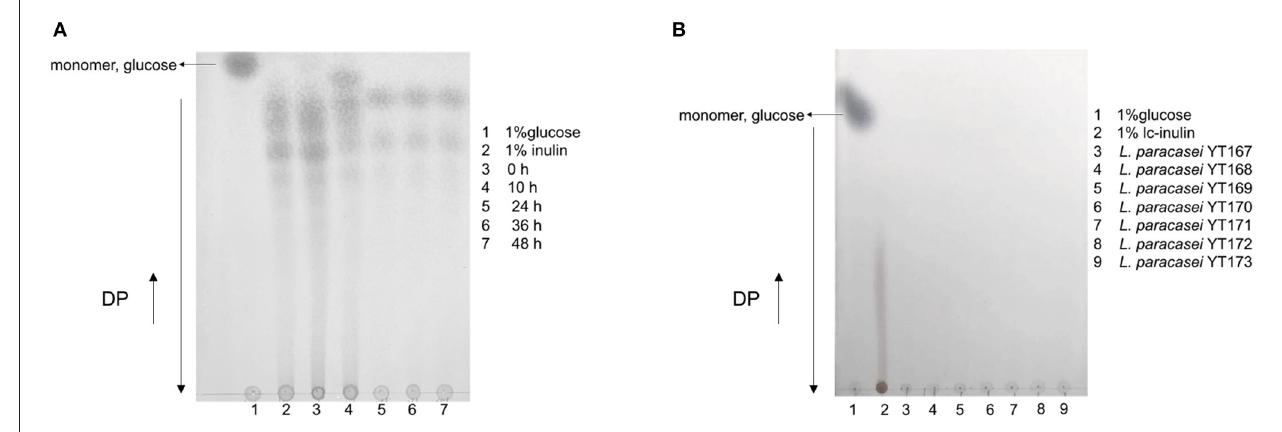
FIGURE 3 | TLC profiling of bacterial culture supernatants at several sampling time-points during fermentation in bMRS broth containing 1% inulin by fermenter Lacticaseibacillus paracasei YT170 (A) and bacterial culture supernatants of long-chain inulin (lc-inulin) by seven L. paracasei strains after 72h (B) . Monomer sugar, glucose, and degree of polymerization (DP) are marked with arrows.